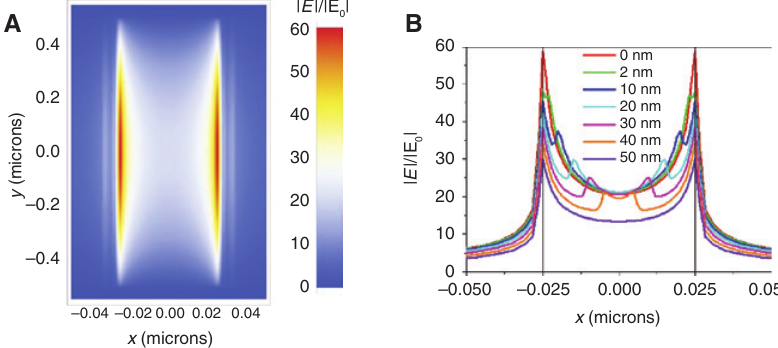
Figure 3: (A) Near-field enhancement map of an empty slit with a width of 50 nm and a length of 1000 nm at its bottom calculated by a FDTD simulation. (B) Near-field enhancement cross section at y = 0 of an empty (0 nm), partly filled (analyte layer thickness between 2 × 2 nm and 2 × 20 nm), and completely filled slit (50 nm). The analyte layers are placed at the sidewalls at x = −0.025 and x = 0.025 μ m, which are indicated by the two maxima from which the fields decay exponentially toward the center of the slit at x = 0. The interfaces between layer and empty slit are revealed by a comparably weak but steep rise of the field, which, correspondingly, is absent for the empty and completely filled